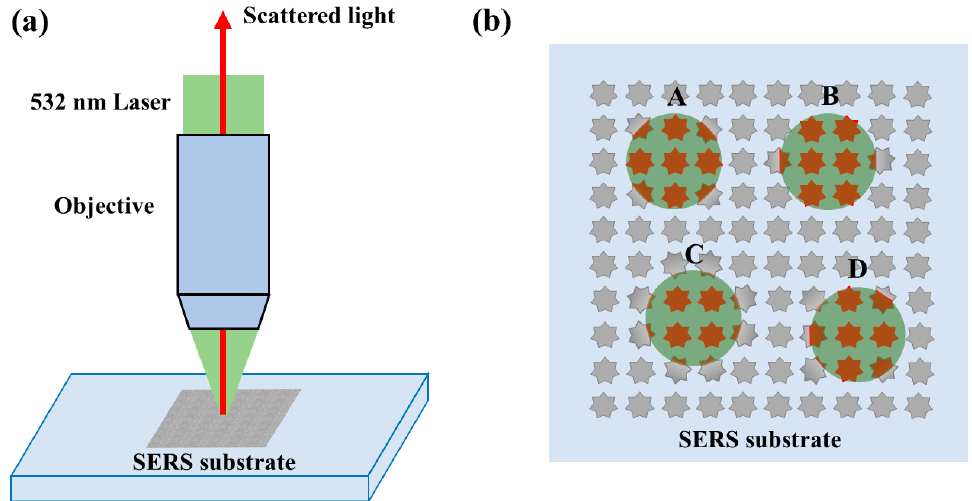
Figure 1. Diagram of a Raman spectrometer: ( a ) Optical setup; ( b ) Different laser focused positions on the SERS substrate.